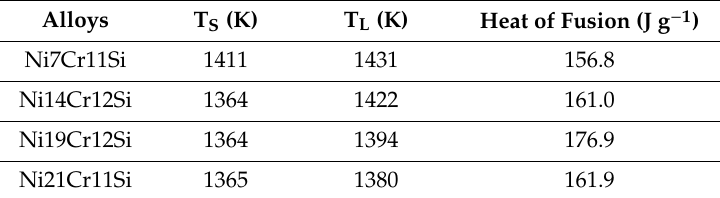
Table 1. Solidus/liquidus temperature and latent heat of fusion of Ni-Cr-Si alloys as measured by DSC.